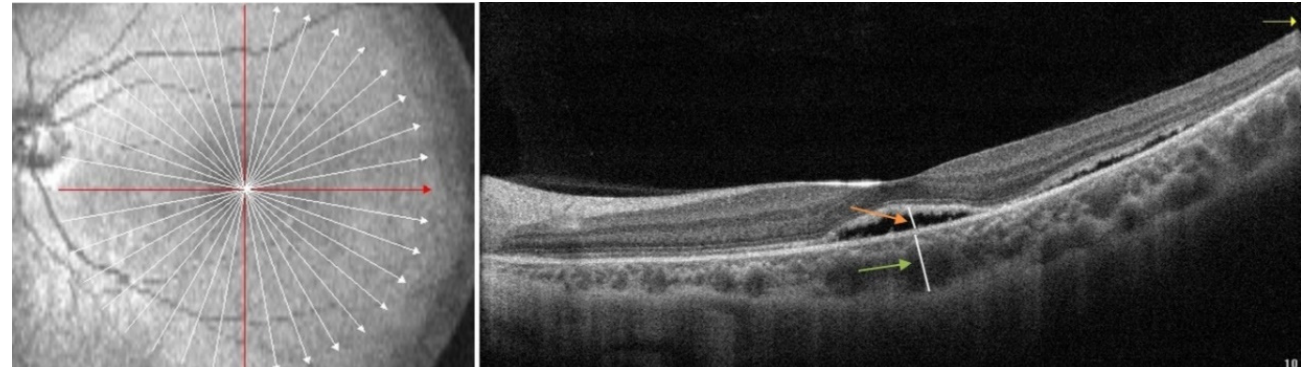
Figure 1. Measurements of the subfoveal choroidal thickness (SFCT) and subretinal fluid height (SRFH). The SFCT is the perpendicular distance from the outer boundary of the retinal pigment epithelium (RPE) layer to the inner border of the sclera (green arrow). The SRFH is the perpendicular distance from the outer boundary of the neuroepithelial layer to the inner border of the RPE layer (orange arrow).